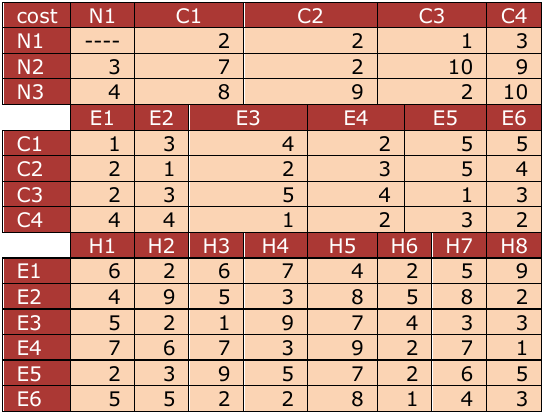
Table 2. Unit cost of medical resources between two different